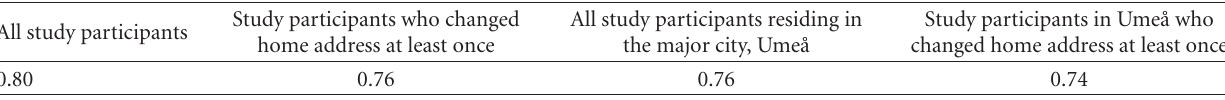
Table 2: Pearson correlation coe ffi cients between study inclusion and follow-up average NO x concentration at home address ( ρ